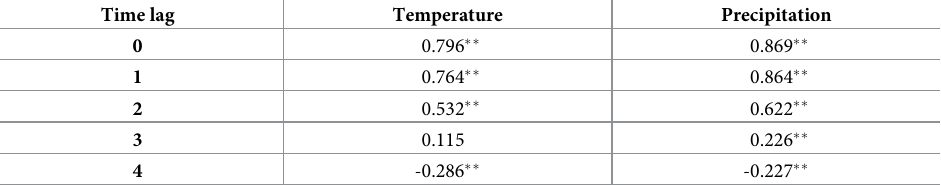
0 indicates the correlation coefficients are calculated by the NDVI and climatic factors in the same month, 1 indicates the correlation coefficients are calculated by the NDVI in the current month and climatic factors in the previous month, etc. �� Significant at level